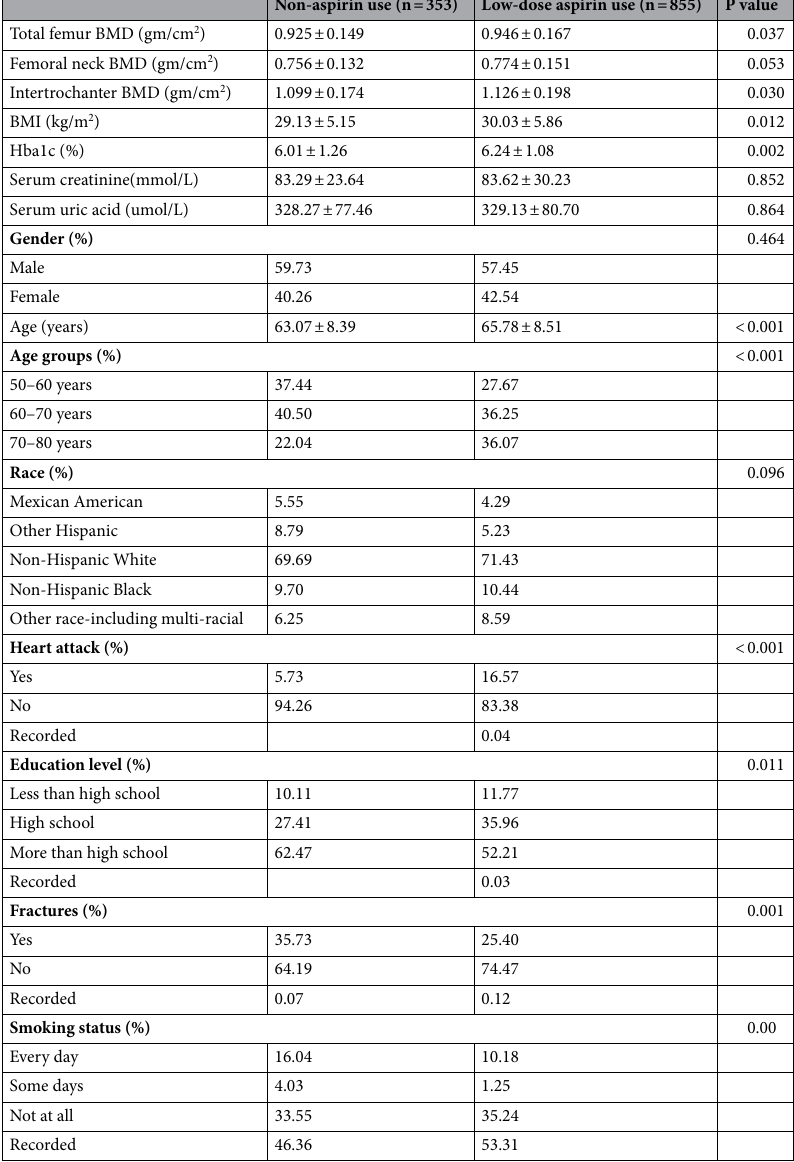
Table 1. Weighted characteristics of study sample non-aspirin users and low-dose aspirin users (Group1: Total femur BMD, Femoral neck BMD, Intertrochanter BMD). Mean ± SD for continuous variables: P value was calculated by the weighted linear regression model. Per cent for categorical variables: P value was calculated by weighted chi-square test. Weights are created in NHANES to account for the complex survey design (including oversampling), survey non-response, and post-stratification adjustment to match total population counts from the Census